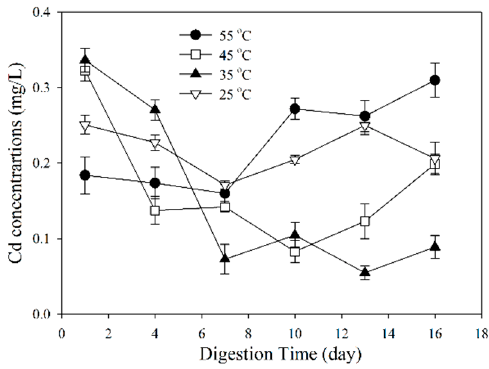
Figure 1. Cd concentrations in the digestion liquor (mg / L) during the anaerobic digestion.